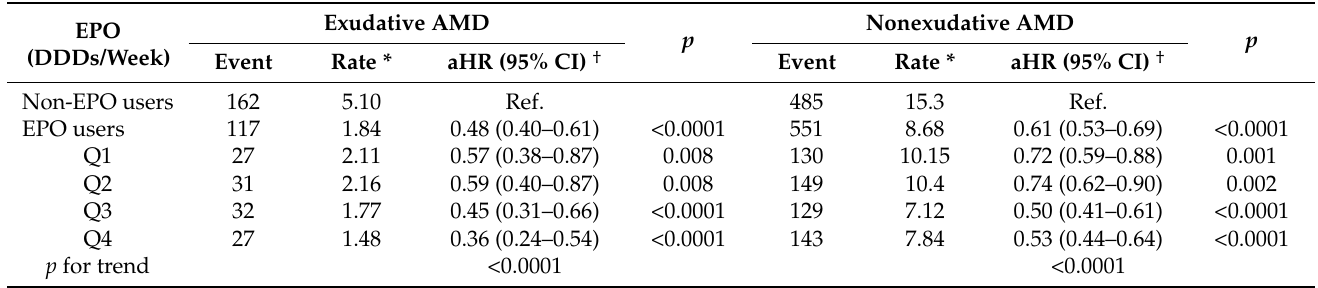
Table 3. Incidence and hazard ratios of subtype age-related macular degeneration in hemodialysis patients by quartile dosage of erythropoietin.